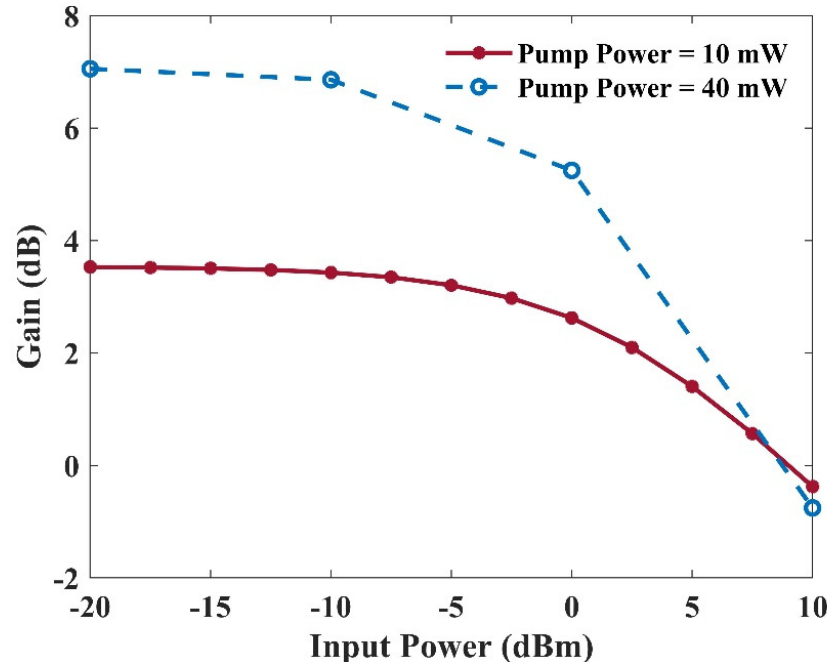
Figure 19. Gain versus input power with a 10 mW or a 40 mW optical pumping power.